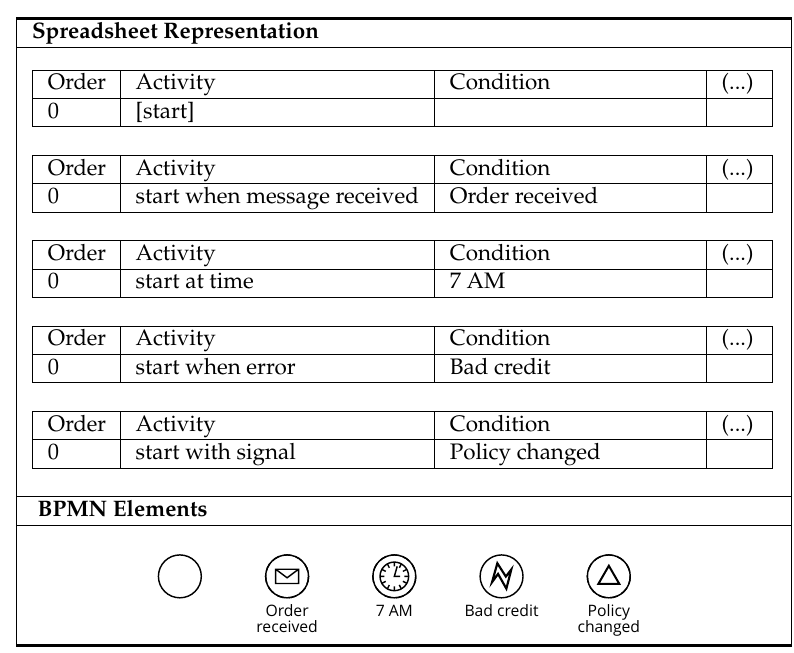
Table 5. Start event examples.